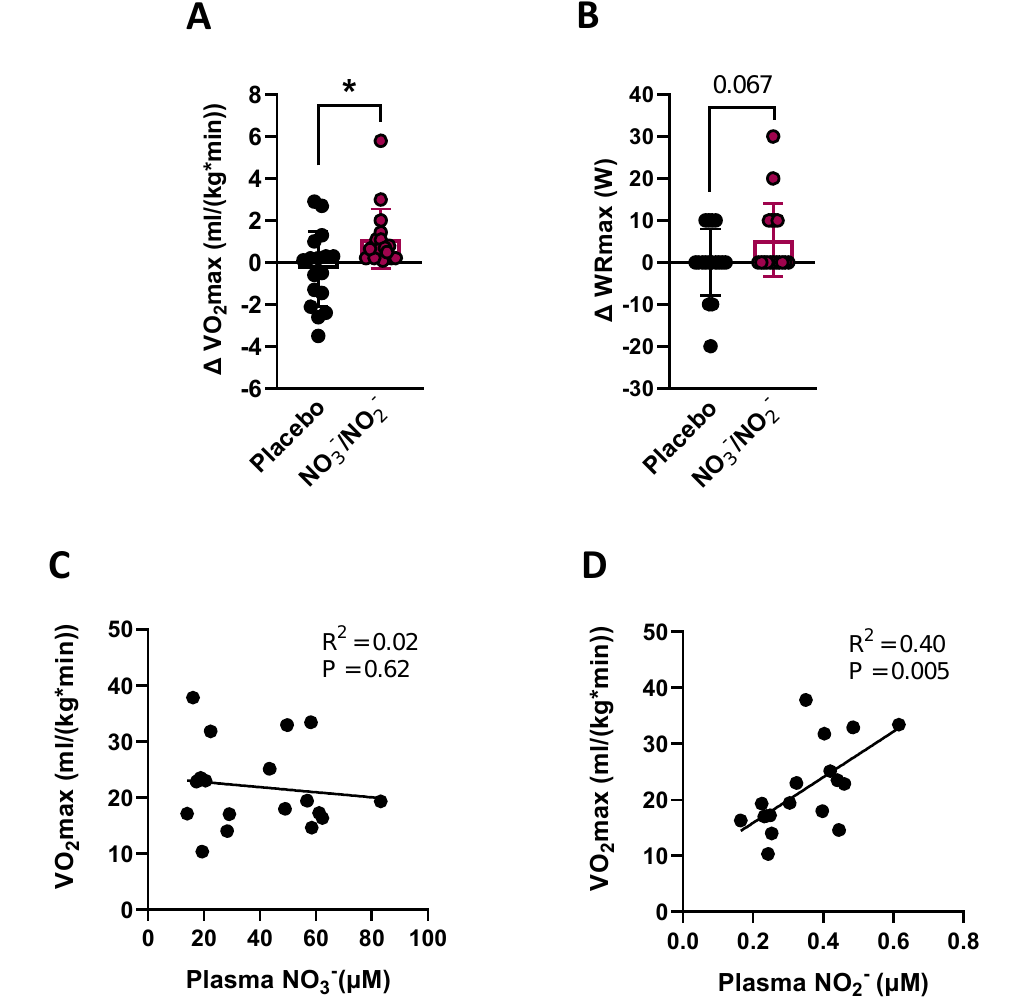
Figure 4. Combined nitrate/nitrite (NO 3 − /NO 2 − ) supplementation increases maximal oxygen uptake capacity (VO 2 max) in T2DM participants. ( A ) ANCOVA results, using pre-supplementation values of VO 2 max as a covariate, showing individual changes (post – pre) for VO 2 max from primary group of T2DM subjects (N = 18/condition). ( B ) ANCOVA results, using pre-supplementation values of maximal work rate (WRmax) as a covariate, showing individual changes (post – pre) for WRmax from primary group of T2DM subjects (N = 18/condition). ( C ) Relationship between plasma NO 3 − and VO 2 max after NO 3 − /NO 2 − supplementation (N = 18; r = 0.14; Slope 95% CI: − 0.237, 0.146). ( D ) Relationship between NO 2 − and VO 2 max after NO 3 − /NO 2 − supplementation (N = 18; r = 0.63; Slope 95% CI: 14.09, 67.34). Data are presented as mean ± SD. * p < 0.05.